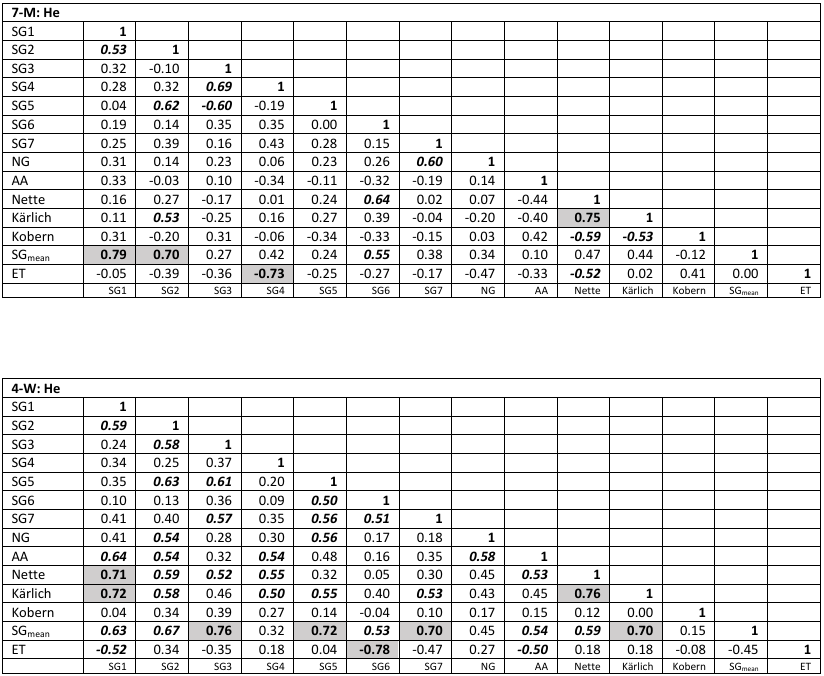
Figure A4. Correlation coefficients between He fluctuation patterns in NG, SG, SG mean , mineral springs, and Earth tides (ET) for the 7-M and 4-W samples. Correlations > 0.70 are shaded. Correlations 0.5–0.7 are marked in